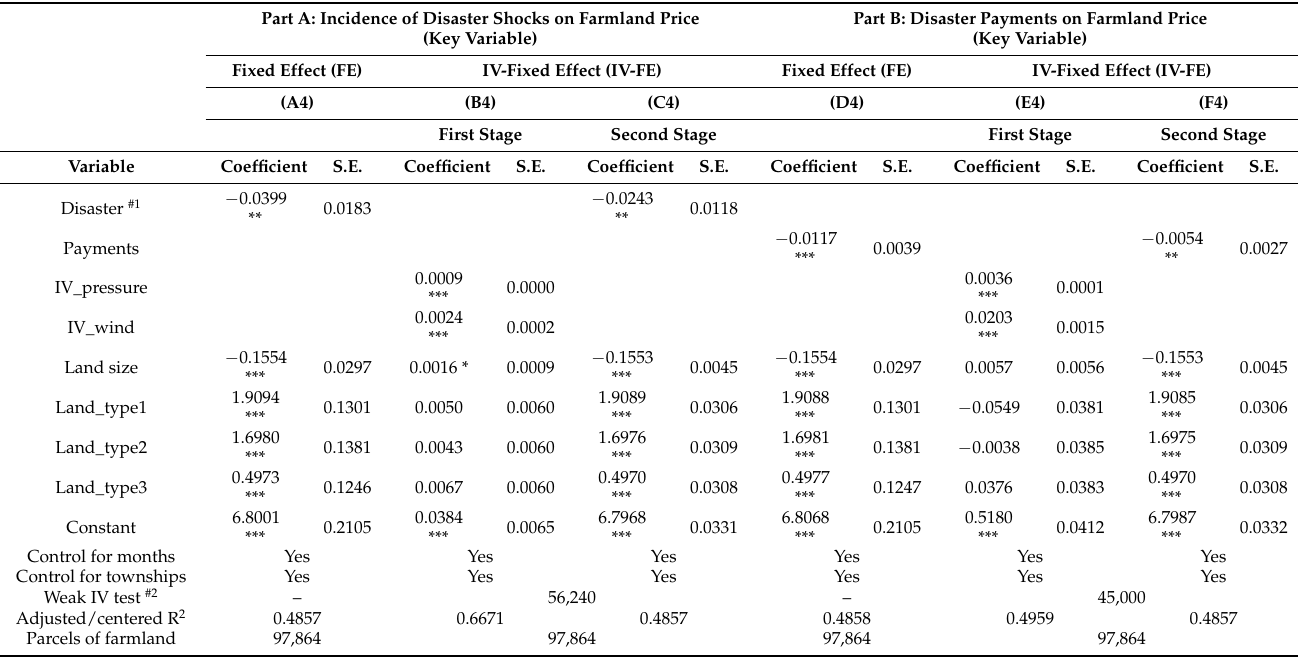
Table 4. Estimation results of the farmland price equation.